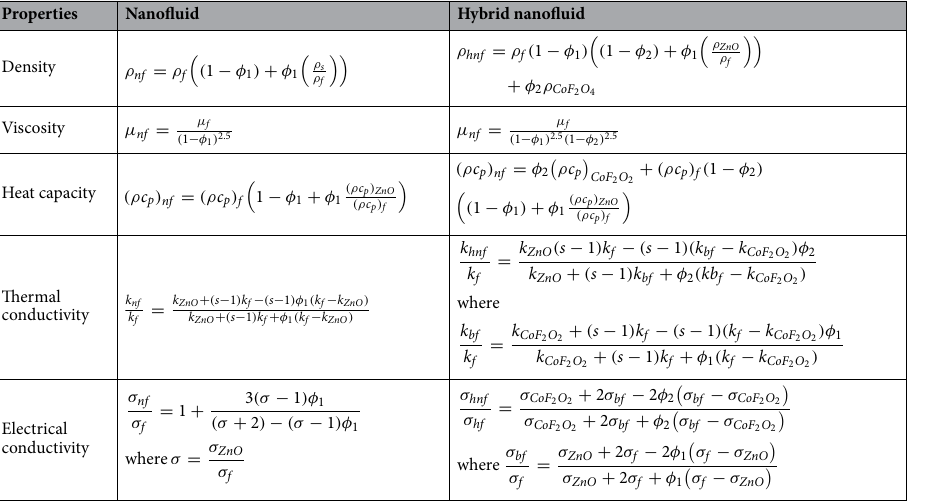
Table 3. Thermo-physical relations for nano and hybrid nanofluids 29,41 .